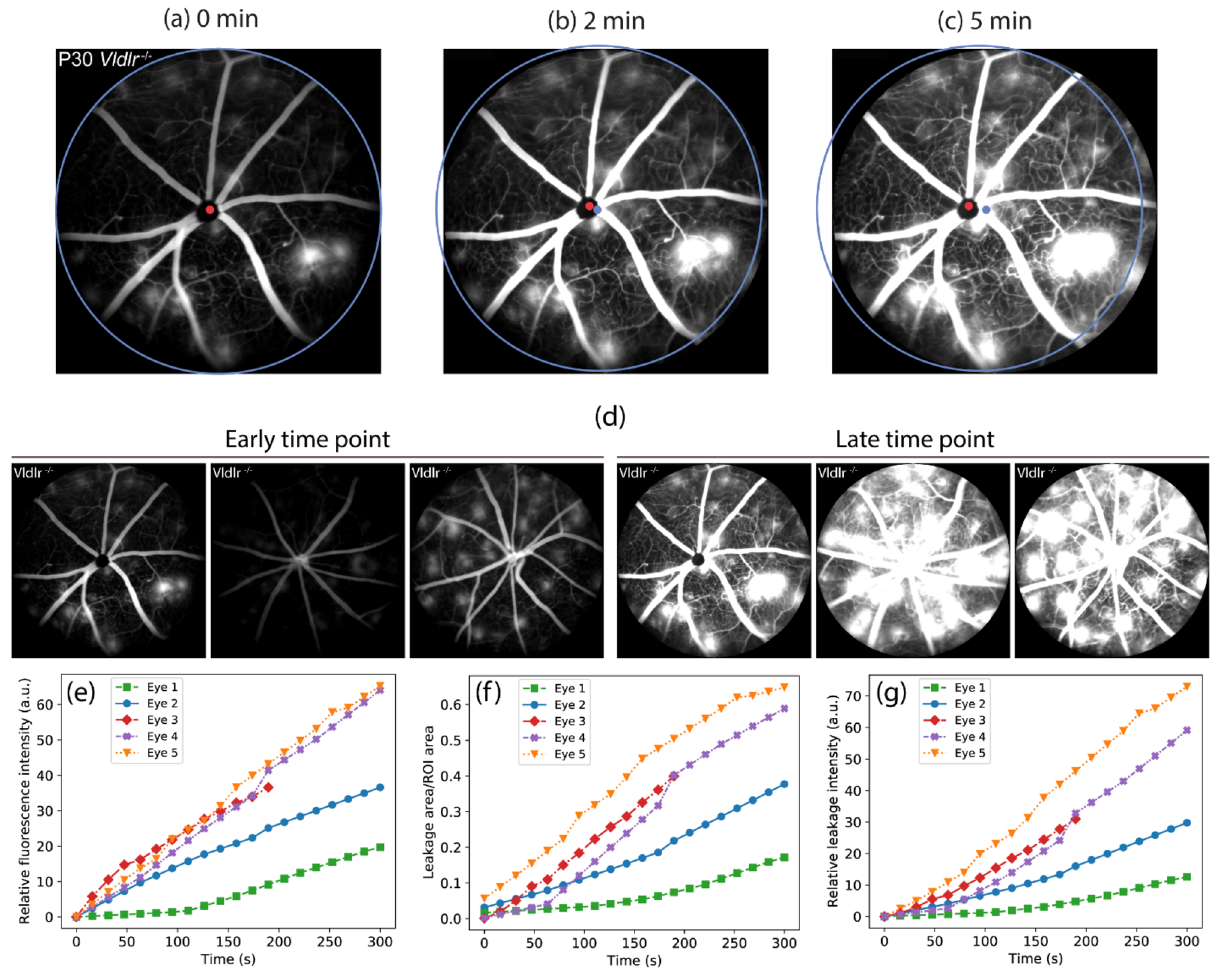
Figure 3. ( a )–( c )Reference point, shown in red, obtained for FFA images from Vldlr −/− mice at different time points. The blue dot indicates the pixel position of the red dot in ( a ) for reference. The blue circle indicates the position of the ROI of the first time point on the subsequent time points and can be used as a visual guide for the movement of the sample along time. ( d – f ) Example of FFA leakage quantification allowed by the leakage segmentation methodology. ( d ) Representative FFA images from Vldlr −/− mice at early and late time points post fluorescein injection, respectively. ( e ) Relative fluorescein intensity as a function of time for FFA images. ( f ) Leakage region divided by ROI area as a function of time calculated for the FFA images (n = 5). ( g ) Relative fluorescein intensity inside the identified leakage regions as a function of time for FFA images (n =